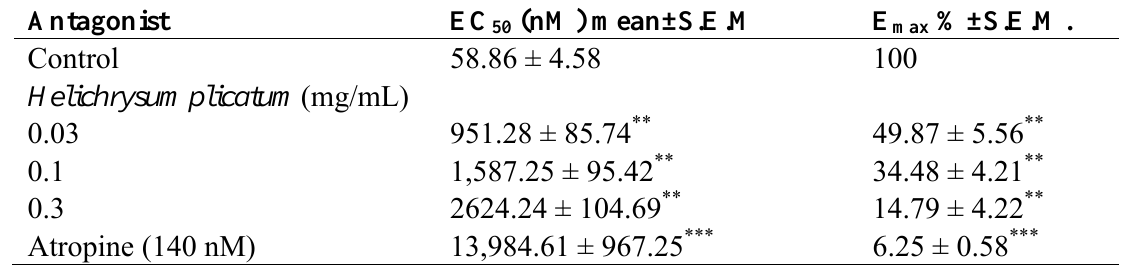
Table 1. EC and E values obtained from the cumulative dose-response curves to acetylcholine. 50 max Antagonist